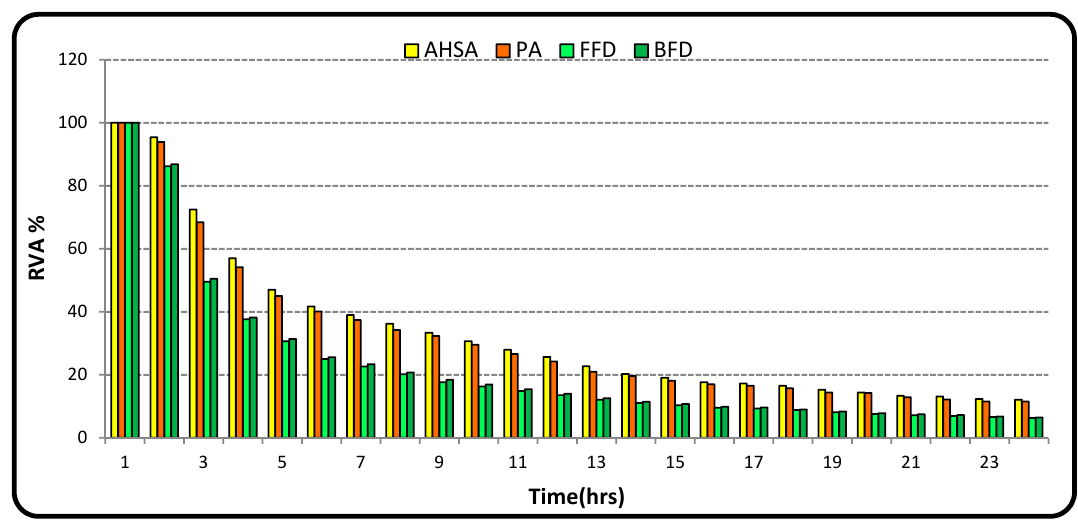
Figure 8. RVA metric of scenario II for a day.